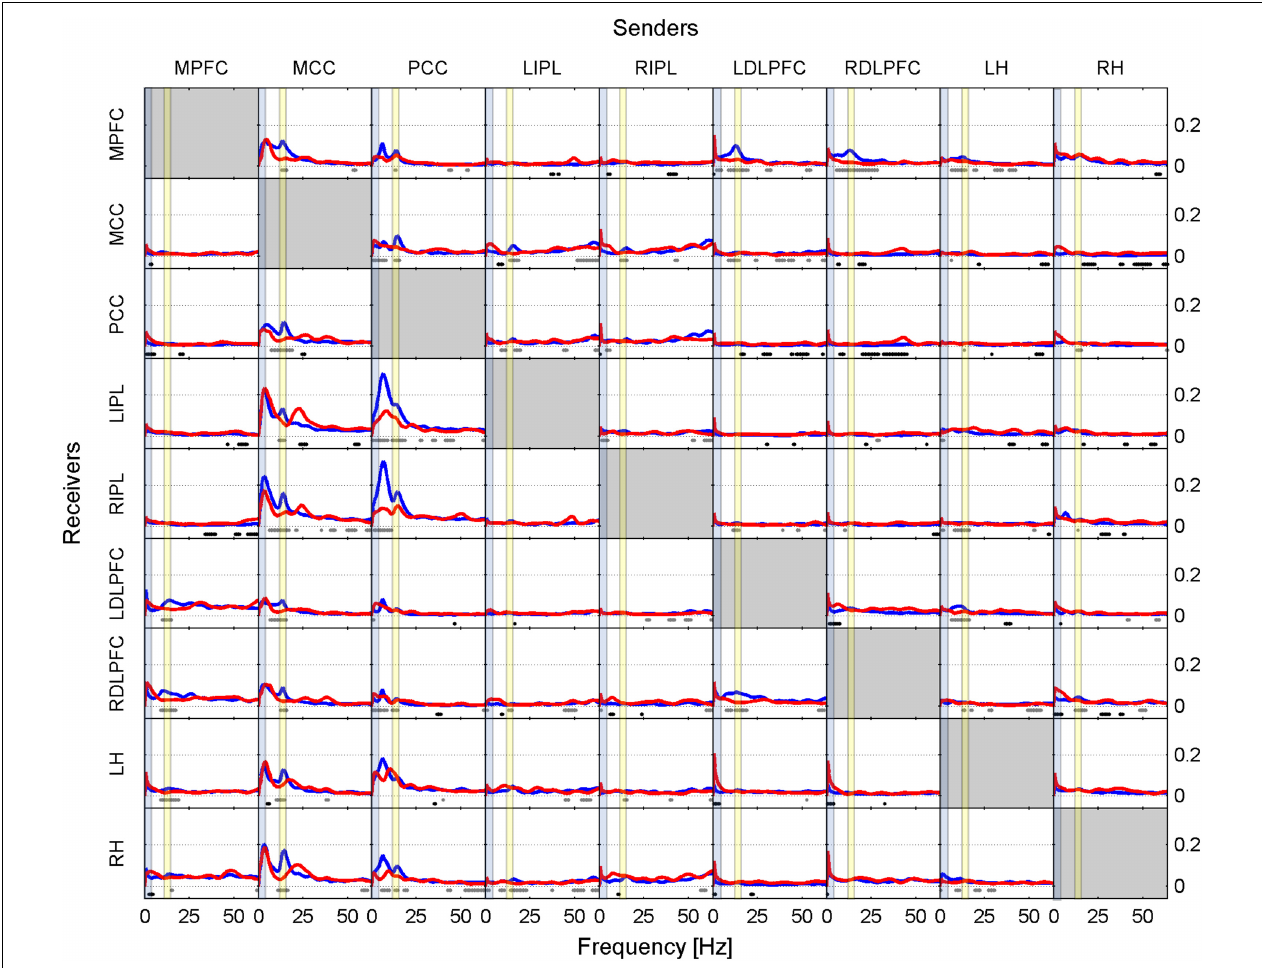
FIGURE 2 | Effective connectivity assessed by iCOH at the SOn transition in recovery after 40 h of sustained wakefulness. For details of the representation see Figure 1